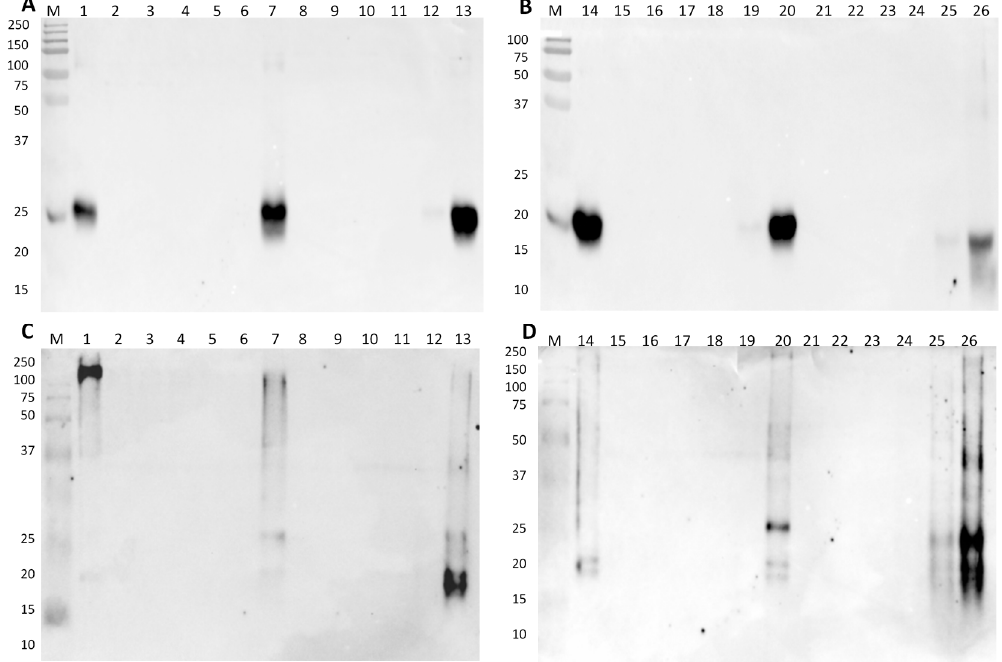
Figure 3. Immunoblot membranes for soybean testing using anti-trypsin inhibitor polyclonal antibody in denaturing ( A , B ) and native conditions ( C , D ) with model mixtures simulating raw and cooked hams ( A and C ) and raw and autoclaved sausages ( B and D ). Legend: lane 1, SPI; lane 2, raw pork ham (0% SPI); lanes 3–7, 0.001%, 0.01%, 0.1%, 1%, and 10% of SPI in raw pork ham; lane 8,